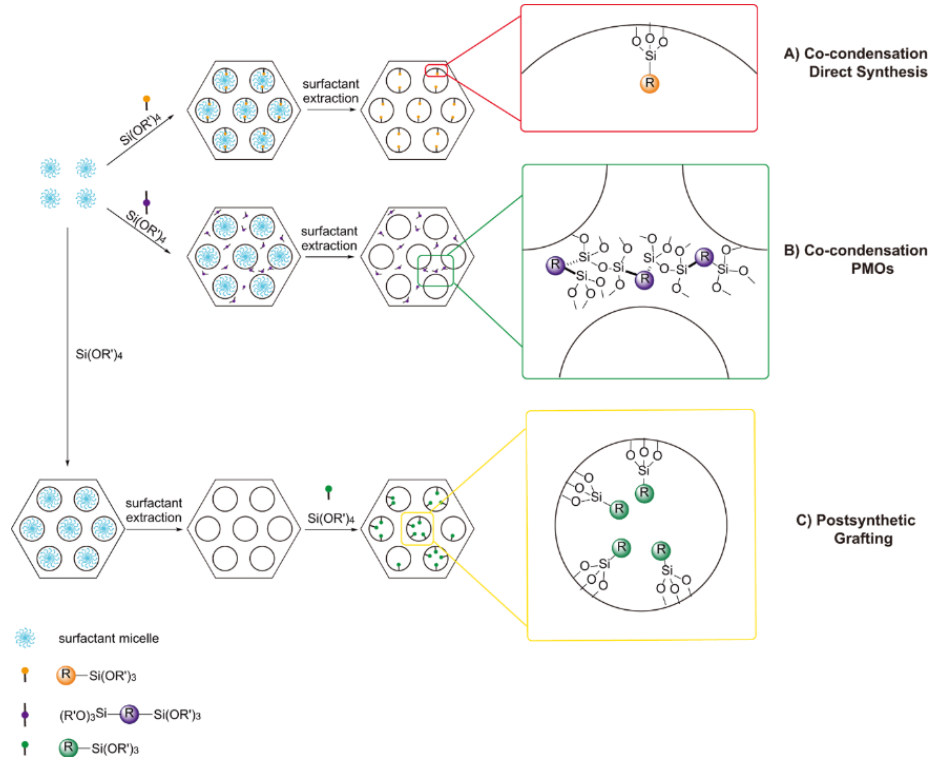
Figure 4. The immobilisation of chemical functionalities by both co-condensation and post synthetic functionalisation. Path ( A ) shows the direct synthetic co-condensation functionalisation by organo- substituted trialkoxysilanes on the surface of silica mesopores. Path ( B ) indicates the co-condensation process for periodic mesoporous organosilicas (PMOs), where bridged organosilanes (R’O) 3 Si-R- Si(OR’) 3 and tetraalkoxysilanes are within the three-dimensional network structure of the silica matrix. Path ( C ) illustrates the post synthetic grafting of terminal